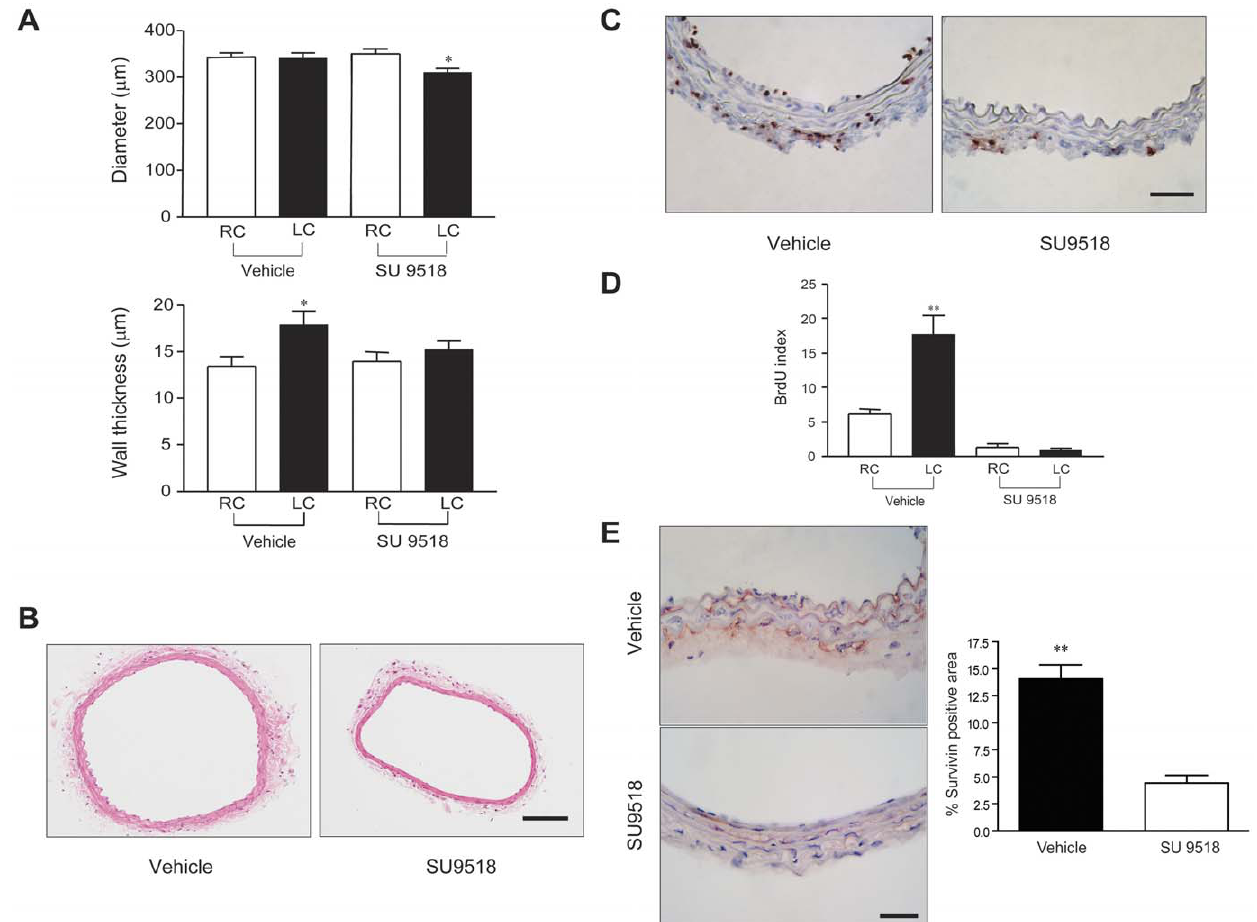
Figure 3. SU9518 decreases cell proliferation and restore normal remodeling in eNOS ( 2 / 2 ) mice. (A), Lumen diameters (upper panel) of LC in SU9518 treated eNOS ( 2 / 2 ) mice were reduced in response to a remodeling stimulus but not in LC of vehicle treated eNOS ( 2 / 2 ) mice. Wall thickness (lower panel) of vehicle treated LC was significantly increased and, SU9518 restored the normal wall remodeling in LC. Values are mean 6 SEM; n=7 for each group of mice; * P , 0.05, ** P , 0.001 with one way ANOVA with Bonferroni posttest. (B) Representative hematoxylin and eosin stained LC cross sections of vehicle or SU9518 treated mice. Inward remodeling can be seen in SU9518 treated LC. Scale bar represents 100 m m. (C), Immunostaining shows BrdU positive cells were detected in all layers of ligated LC in vehicle treated mice (left panel), which blocked by SU9518 treatment as shown on the right panel. Scale bar represents 25 m m. (D), Quantitative BrdU index shows cell proliferation was significantly increased in vehicle treated LCs of eNOS ( 2 / 2 ) mice, but not in vessels from SU9518 treated eNOS ( 2 / 2 ) mice. (E) PDGF-BB receptor tyrosine kinase inhibitor decreases immunoreactive survivin levels in LC of eNOS ( 2 / 2 ) mice, compared to vehicle treated eNOS ( 2 / 2 ) mice (left panel). Right panel shows the quantification of percentage of suvivin positive staining in total vessel area. Values are mean 6 SEM; n=5. * P , 0.05, ** P , 0.001 with one way ANOVA with Bonferroni posttest.